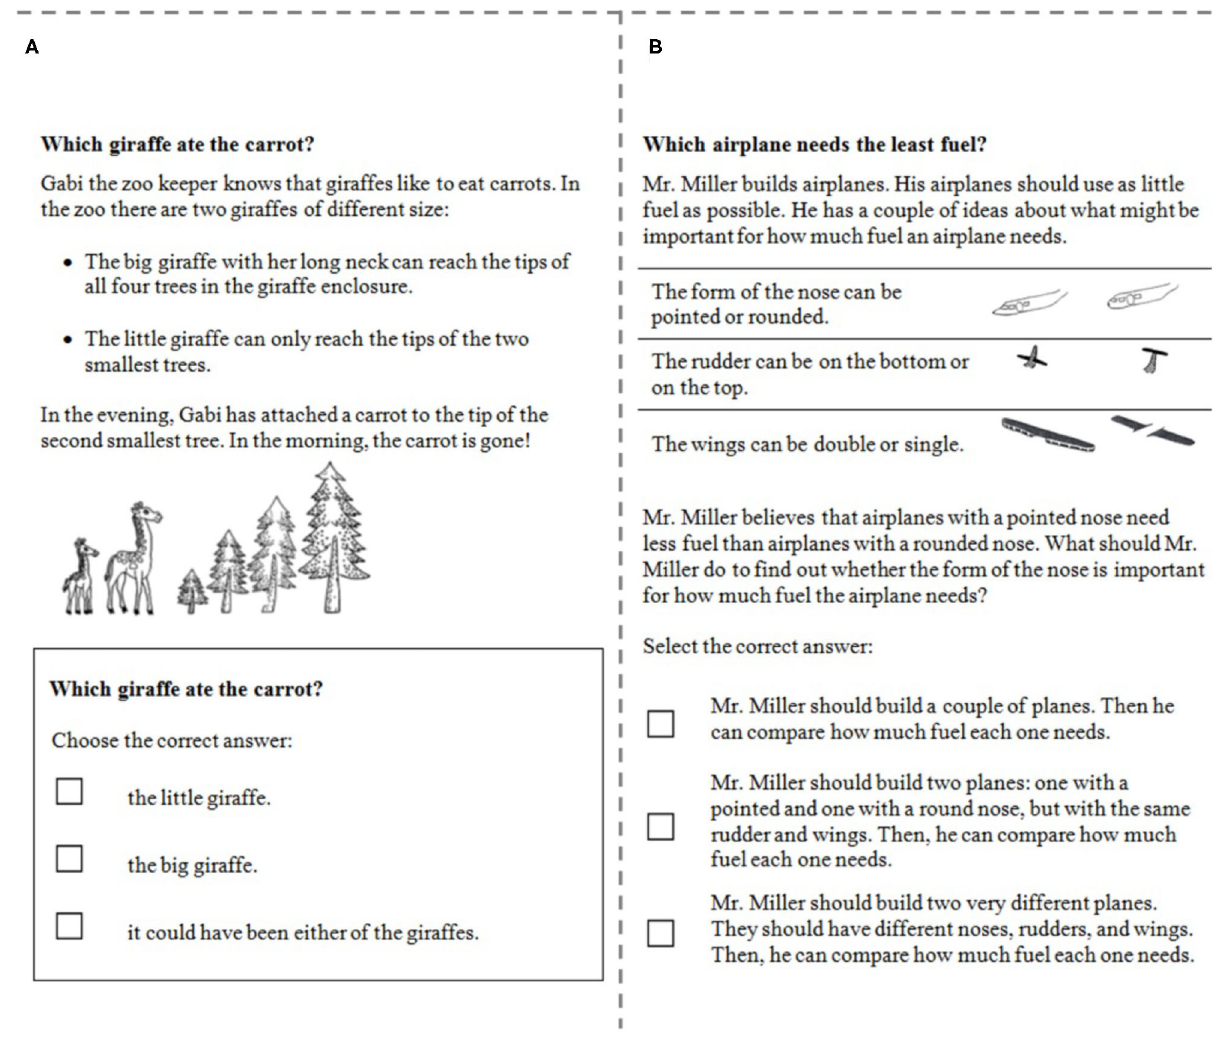
FIGURE 1 | Example items from the assessment of the precursor skills of understanding indeterminacy (A) and confounding (B)